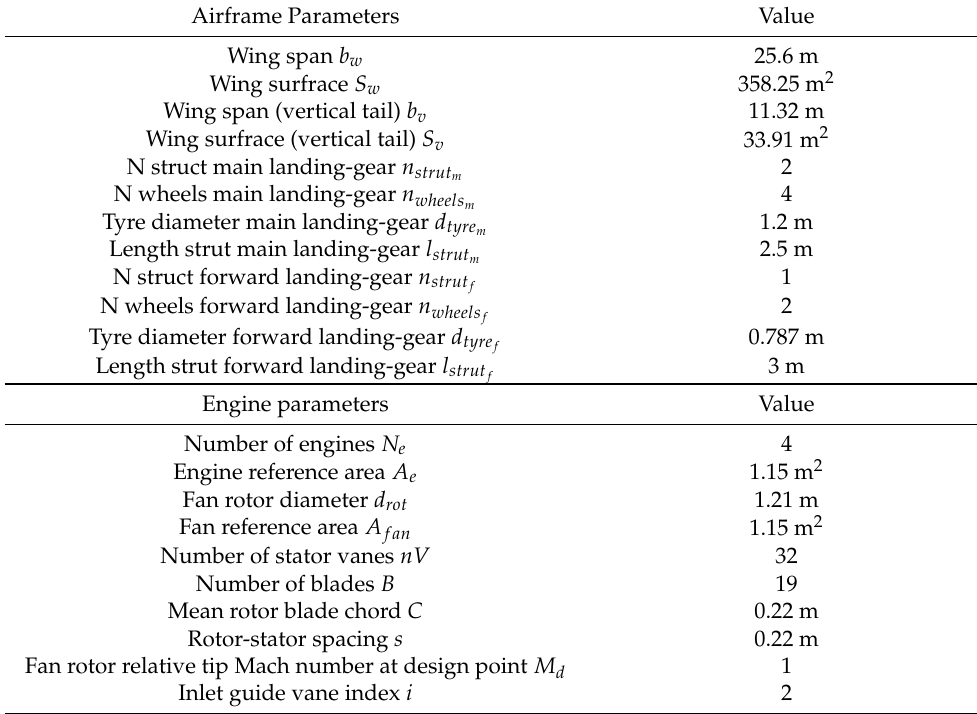
Table 4. Case study geometrical parameters affecting noise